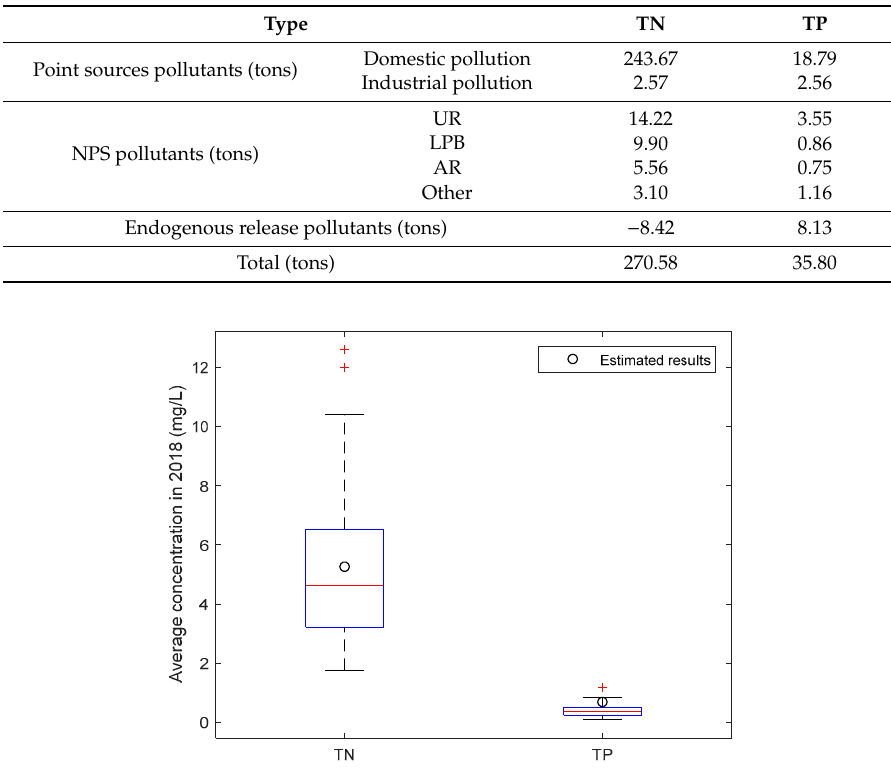
Table 7. All pollution loads emission into rivers in 2018.